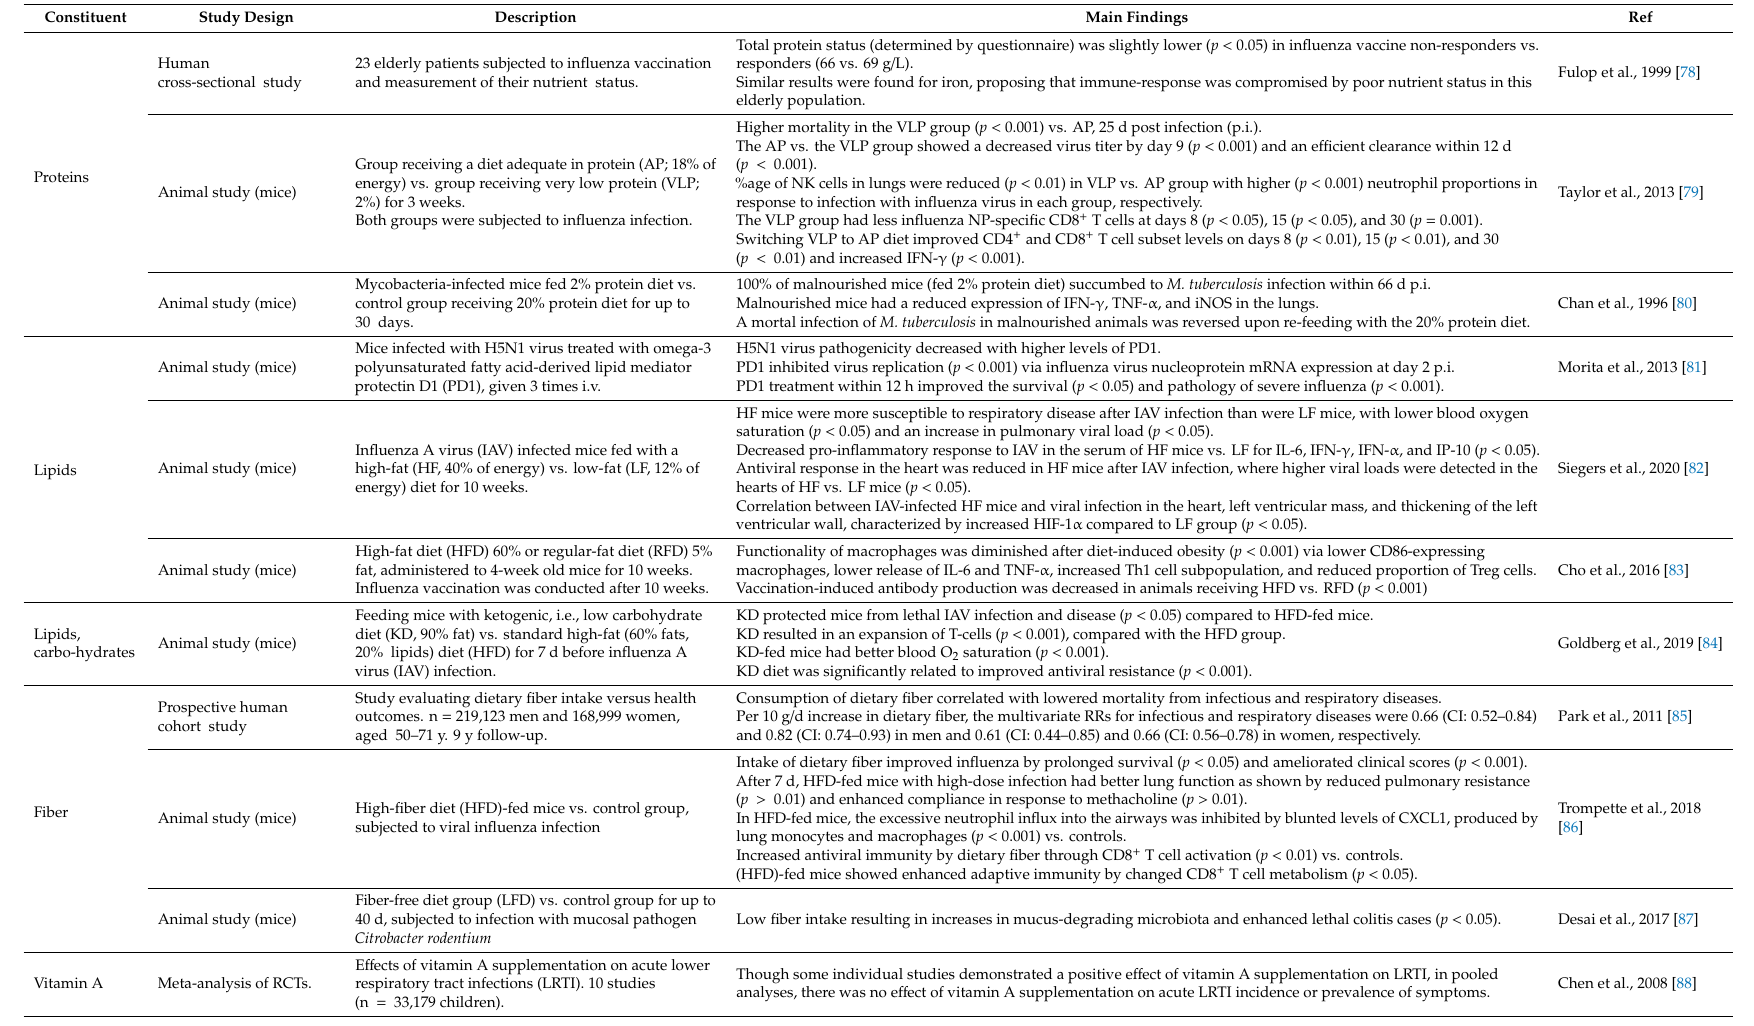
Table 1. Selected studies associating dietary constituents with viral or other infection risk and